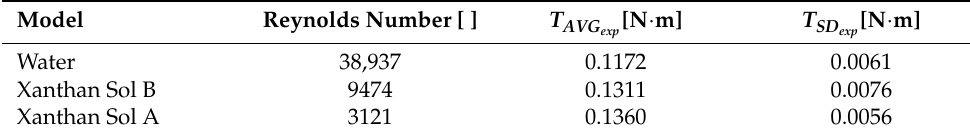
Table 4. Experimental characterization of the abiotic systems.